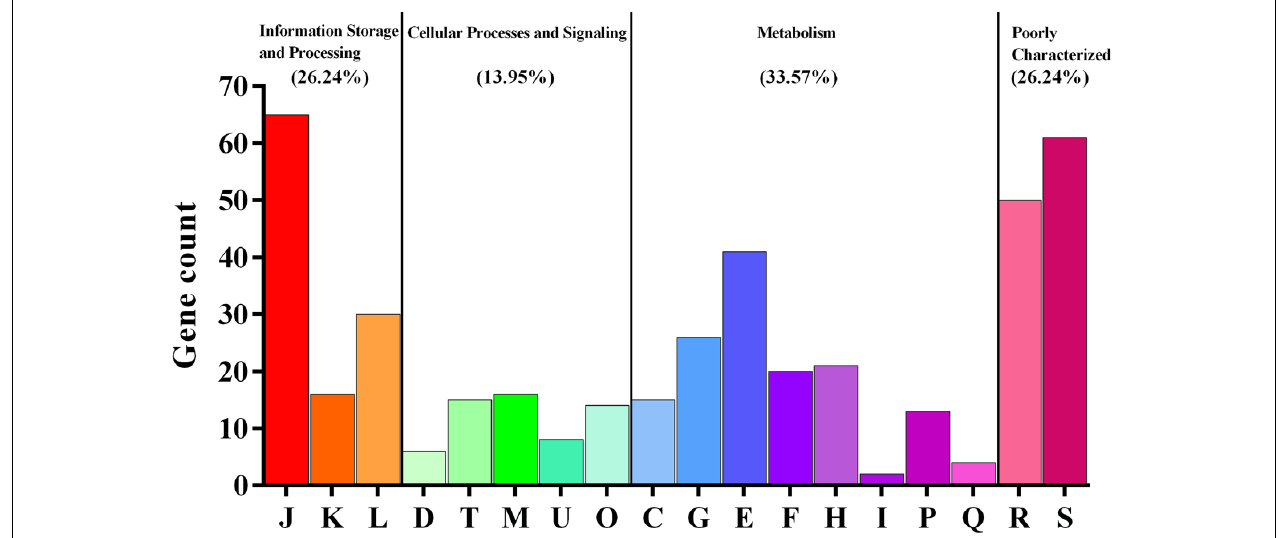
FIGURE 1 | Core genes of Lactobacillus reuteri using the COG database. J, translation, ribosomal structure and biogenesis; K, transcription; L, replication, recombination and repair; D, cell cycle control, cell division, chromosome partitioning; T, signal transduction mechanisms; M, cell wall/membrane/envelope biogenesis; U, intracellular trafficking, secretion, and vesicular transport; O, posttranslational modification, protein turnover, chaperones; C, energy production and conversion; G, carbohydrate transport and metabolism; E, amino acid transport and metabolism; F, nucleotide transport and metabolism; H, coenzyme transport and metabolism; I, lipid transport and metabolism; P, inorganic ion transport and metabolism; Q, secondary metabolites biosynthesis, transport and catabolism; R, general function prediction only; S, function unknown.